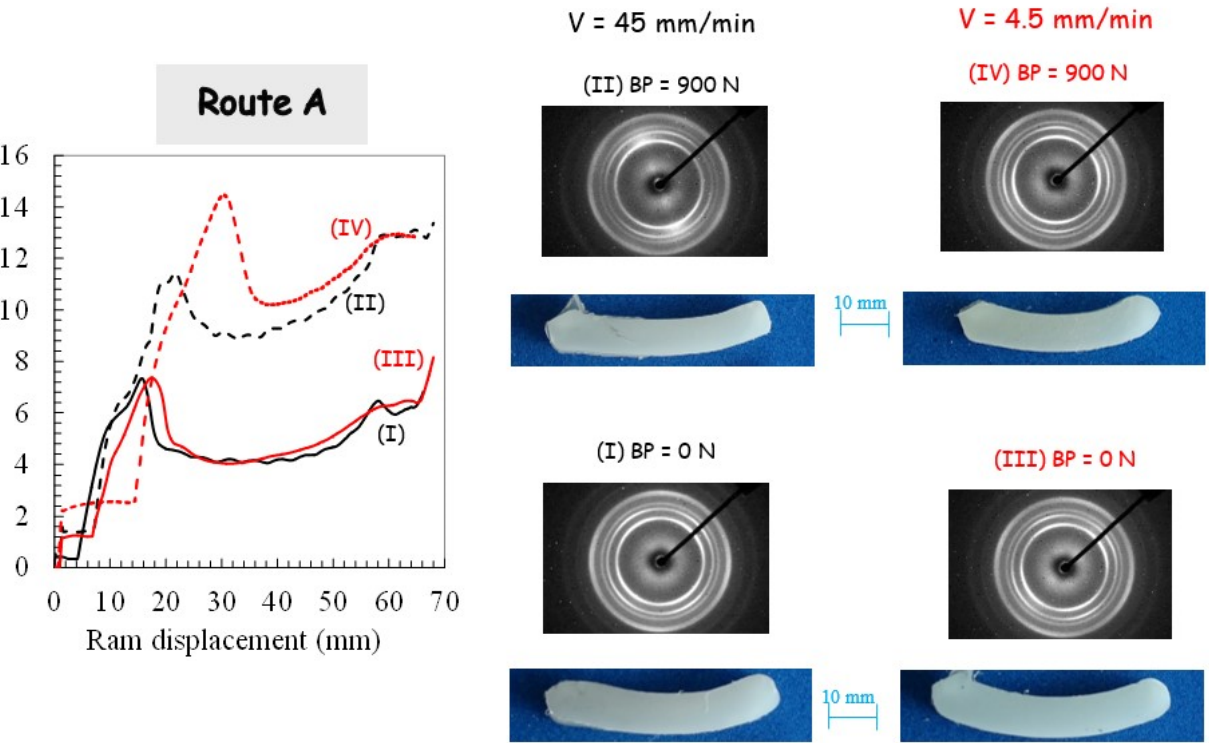
Figure 4. Results of the second pass extrusion in route A in terms of load-displacement curve, deformation behavior and X-ray diffraction for different processing parameters: ( I ) Ram velocity of 45 mm/min and BP of 0 N, ( II ) Ram velocity of 45 mm/min and BP of 900 N, ( III ) Ram velocity of 4.5 mm/min and BP of 0 N, ( IV ) Ram velocity of 4.5 mm/min and BP of 900 N.